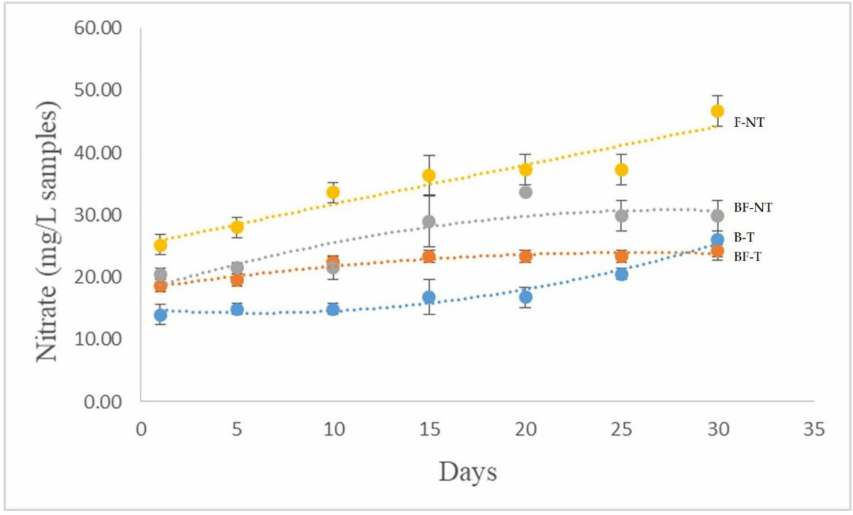
Figure 4. Nitrate release at five day intervals for 30 days of a water incubation experiment.